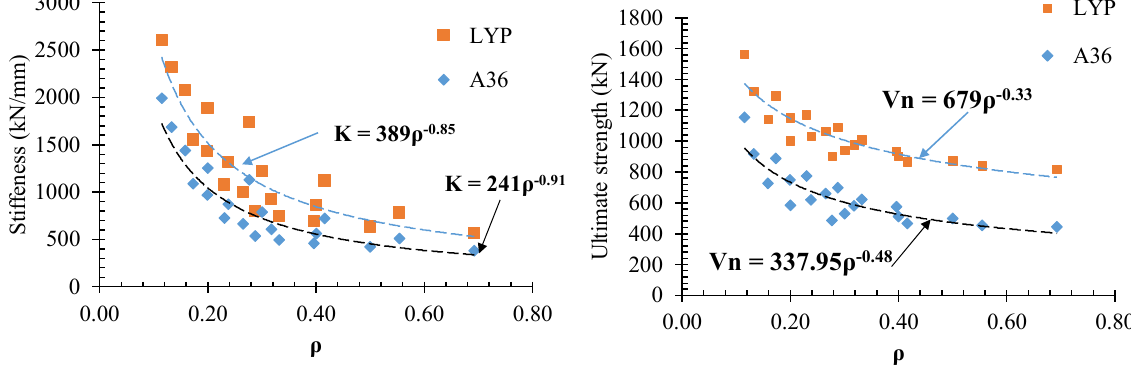
Figure 8. The ultimate strength and stiffness of dampers are plotted versus ρ .